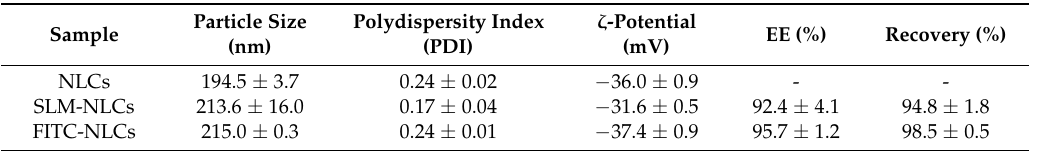
Table 2. Physical and chemical properties of empty NLCs, SLM-NLCs and Fluorescein isothiocyanate-NLCs (FITC-NLCs). Results are expressed as means ± standard deviation, n = 3.